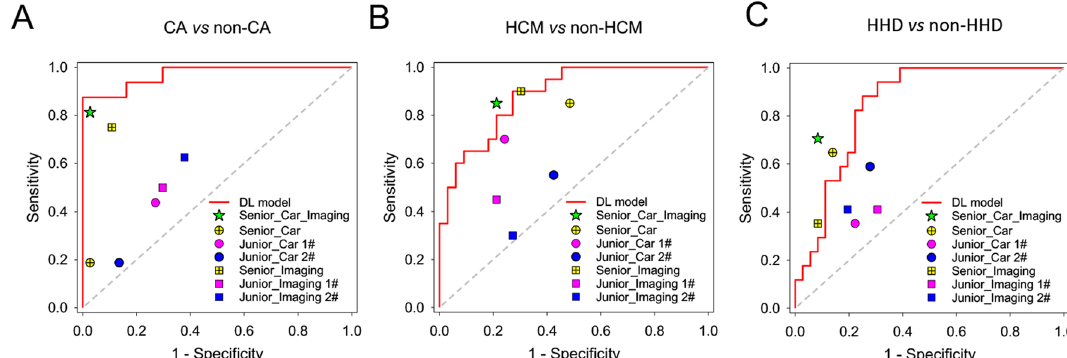
Fig. 6 Comparison between the deep learning model (Model 3) and radiologists/cardiologists for the binary classification of CA ( A ), HCM ( B ) or HHD ( C ) in the external test dataset. HCM, hypertrophic cardiomyopathy, CA, cardiac amyloidosis, HHD, hypertensive heart disease, DL, deep